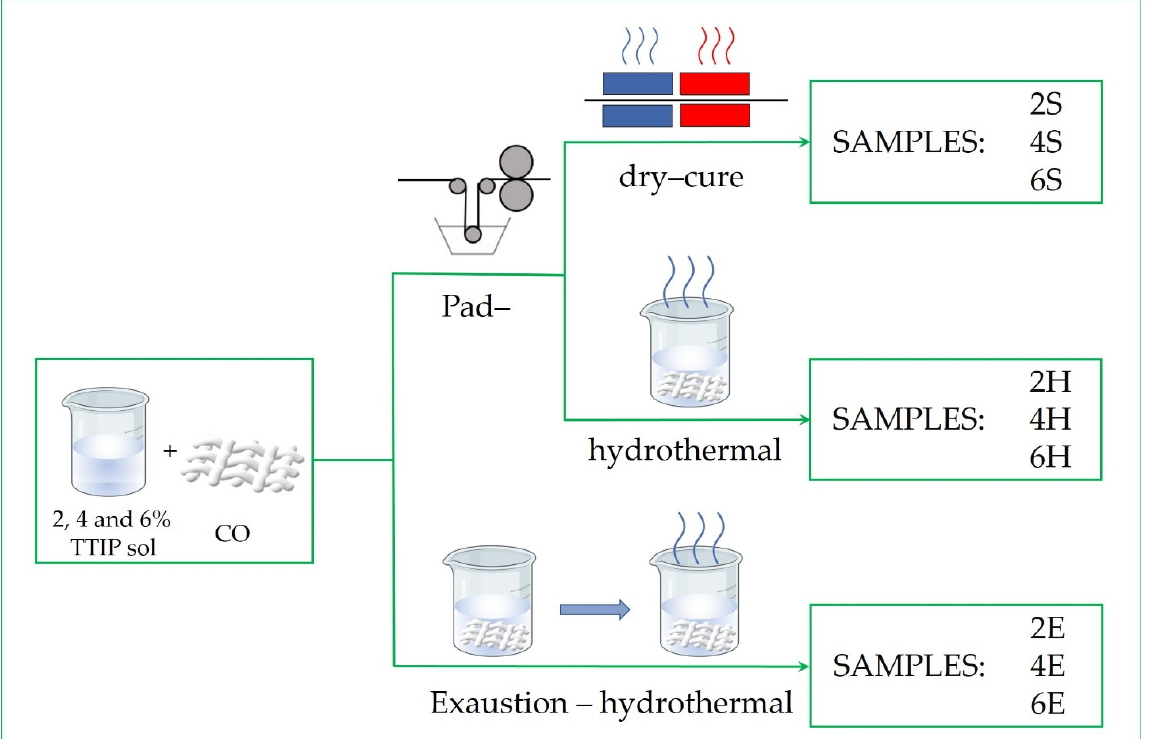
Figure 8. Schematic presentation of the studied in-situ low-temperature application routes.